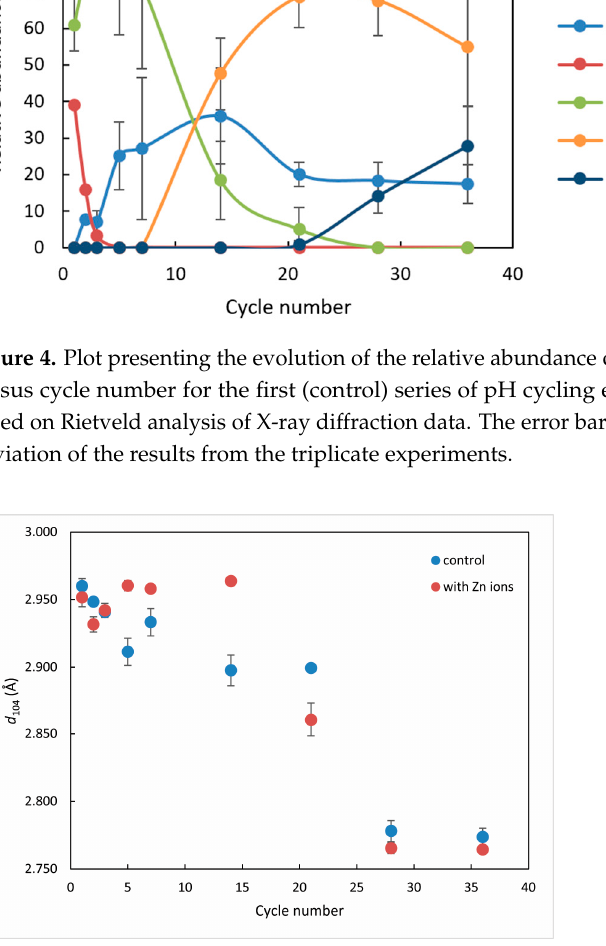
Figure 5. Plot of d 104 spacing of the (very) high magnesium calcite or magnesite phase versus cycle number. The data are presented for both the first (control) series and the second (with zinc ions) series of pH cycling experiments. The error bars (in light grey) are based on the standard deviation of triplicate experiments.